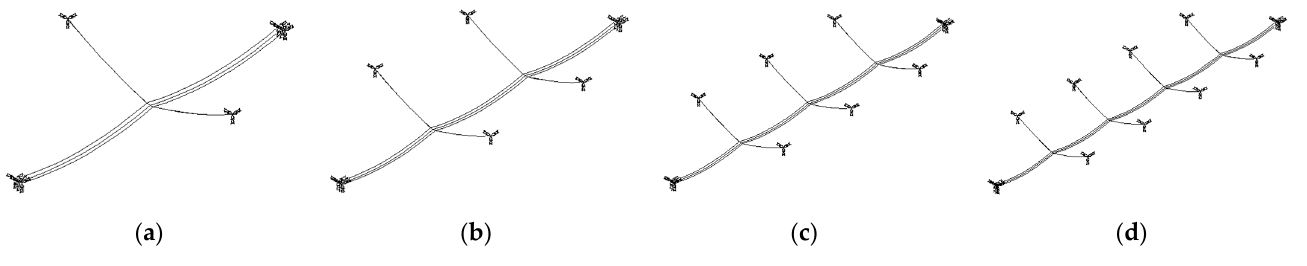
Figure 4. FE models of long-span cross-rope suspension lines with multi-spans of conductors. ( a ) Two spans, ( b ) 3 spans, ( c ) 4 spans, ( d ) 5 spans.